Question: In a single sentence, describe what this figure presents.
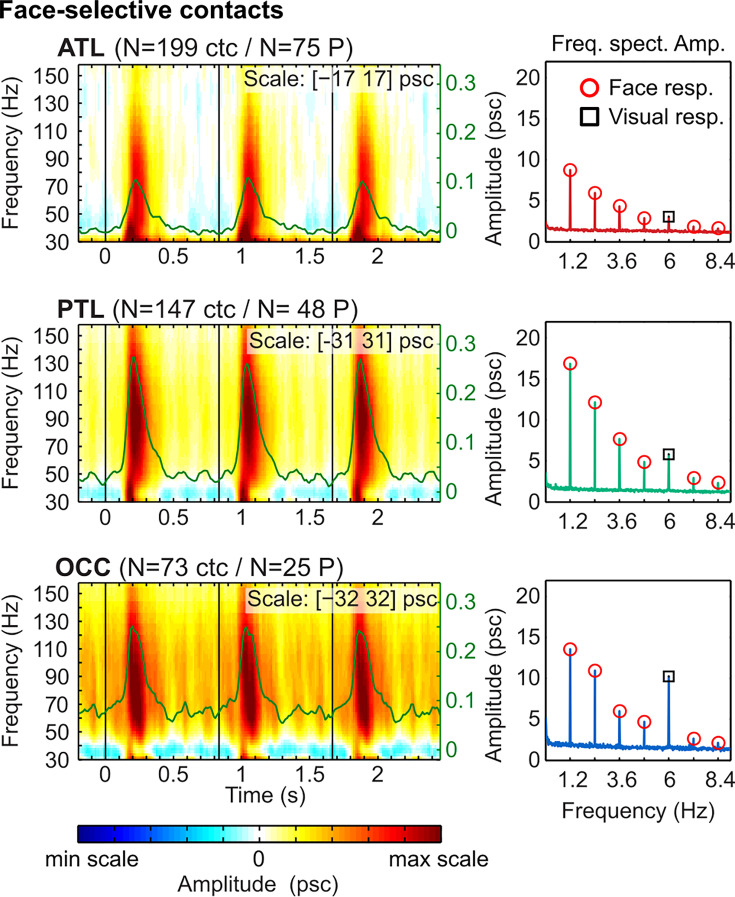
Answer: Time-domain face-selective periodic increases. Left column: Time by frequency response (percent signal change, psc; see scale value at the top of each plot, as well as number of recording contacts/participants, and color scale at the bottom) in the HFB range (30–160 Hz) averaged over face-selective contacts in each main VOTC region (OCC: occipital, bottom; PTL: posterior temporal lobe, middle; ATL: anterior temporal lobe, top). For each recording contact, the time-frequency data was segmented in epochs of about three face cycles (i.e. 3×0.833 s), averaged by contacts and then averaged over the three groups of contacts. Frequency axis is on the left. Green traces are the HFB amplitude envelope obtained by averaging over the 30–160 Hz range. Amplitude (psc) axis is on the right, shown in green. Right column: Frequency spectra averaged over the corresponding groups of recording contacts and showing the face-selective response (red circles) at multiples of 1.2 Hz (i.e. face stimulation frequency) and visual response at 6 Hz (black square, other harmonics not shown). This highlights the sharp decrease in general visual response (i.e. 6 Hz) relative to face-selective response from posterior to anterior VOTC.